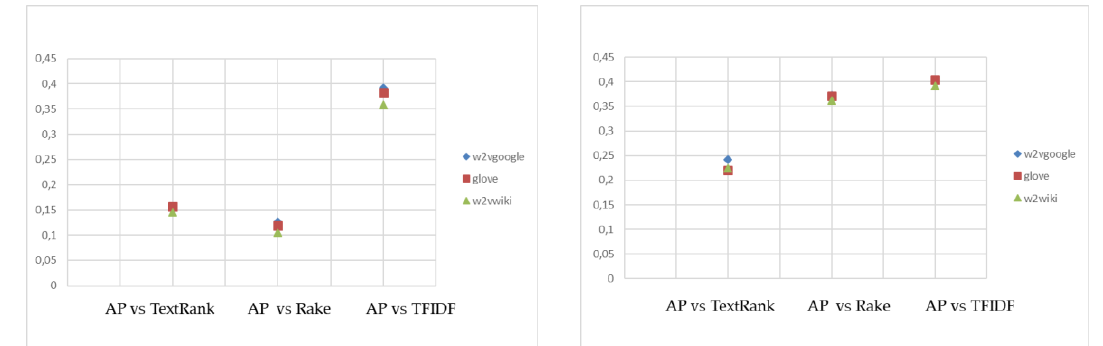
Figure 5. Comparison of results of this method (using AP clustering and Cosine similarity) with baseline on 1-g (on the left) and n -grams (on the right).